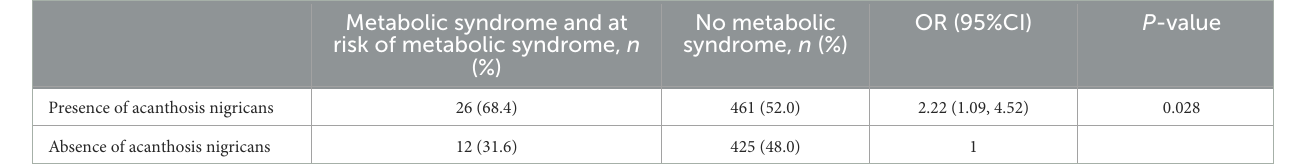
TABLE 6 The association between acanthosis nigricans and metabolic syndrome. Metabolic syndrome and at risk of metabolic syndrome,